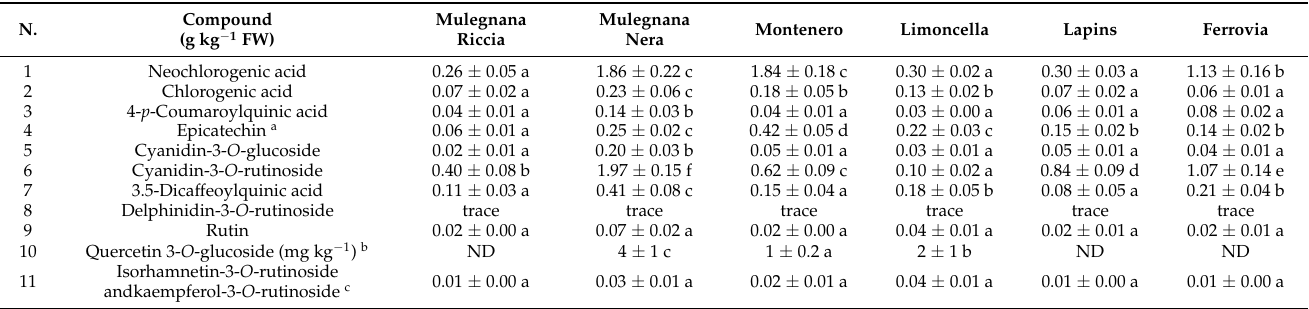
Table 3. Assignment and semi-quantification of HPLC-separated phenolic compounds in the four sweet cherry accessions (Mulegnana Riccia, Mulegnana Nera, Montenero and Limoncella) compared to two standard cultivars (Lapins and Ferrovia). Data represent means ± SD. The same letters indicate non-significant differences (Tukey test) between